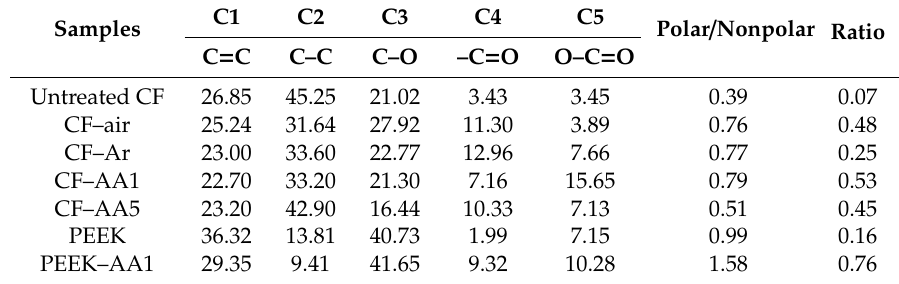
Figure 10. Possible mechanism of surface group oxidation by plasma treatment: ( a ) generation of C–O bonds, ( b ) generation of C=O bonds, ( c ) generation of O–C=O bonds. Table 5. Deconvolution of C1s and the concentration of relevant functional groups from XPS.